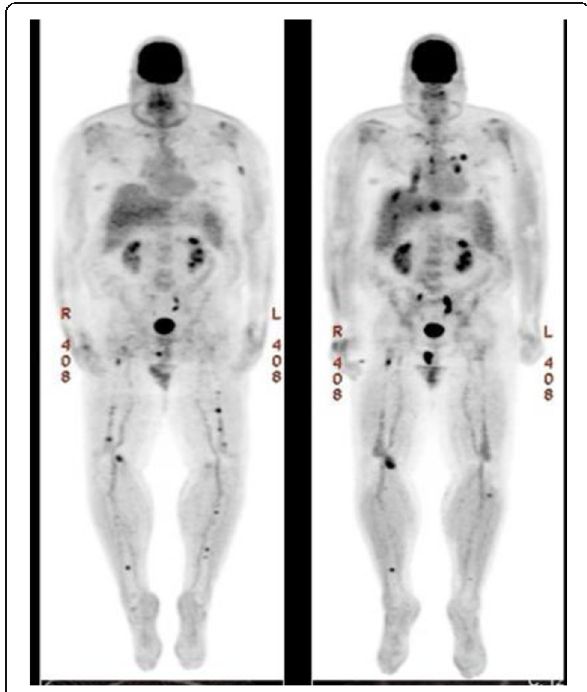
Fig. 2 PET-CT image (left) showing the lesions in the proximal right tibia, right proximal femur and perineum. PET-CT image (right) demonstrate increased size of the previous lesions and new lesions in the left mandibular soft tissue, liver, lungs and mediastinum three months after first time